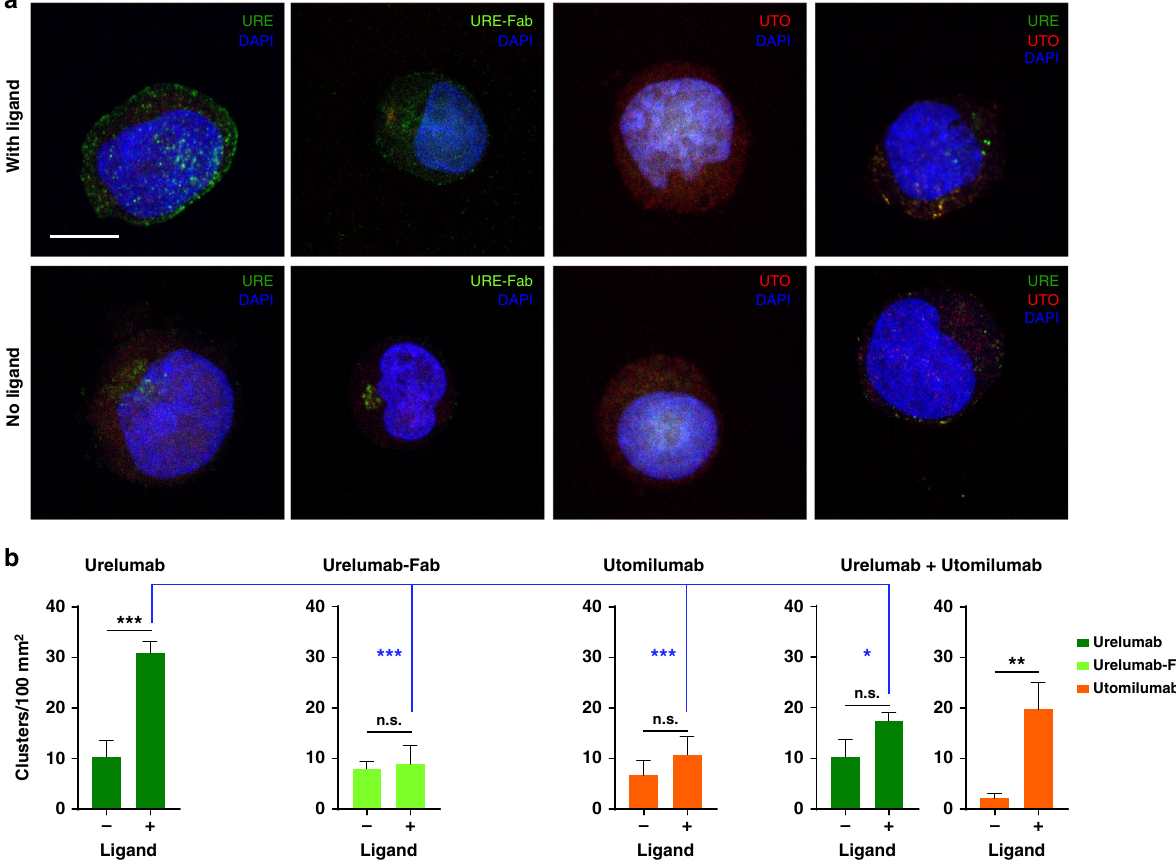
Fig. 8 Differential clustering of 4-1BB receptors on Jurkat cells induced by urelumab and utomilumab. a Confocal images of 4-1BB receptor co-clusters with Urelumab-Alexa Fluor 488 conjugate (URE, green), Urelumab-Fab Alexa Fluor 488 Conjugate (URE-Fab), Utomilumab Alexa Fluor 594 conjugate (UTO, red), or with a combination of URE and UTO in the presence (top row) or absence (bottom row) of 4-1BB His-Avi ligand. Nuclei are stained with DAPI (blue). Scale bar = 10 µ m. b Numbers of observed clusters per 100 µ m 2 of cellular area. Data shown as mean + S.E.M., N = at least 10 cells from three independent experiments. * p -value ≤ 0.05; ** p -value ≤ 0.01; *** p -value ≤ 0.001; n.s., not signi fi